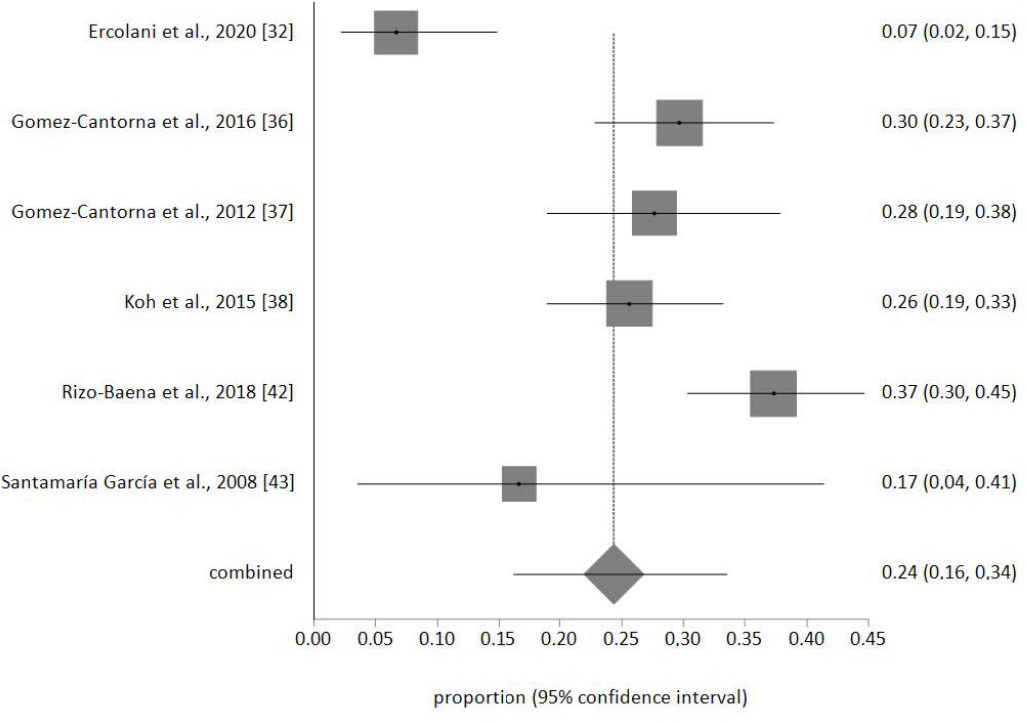
Figure 2. Forest plot of high EE.